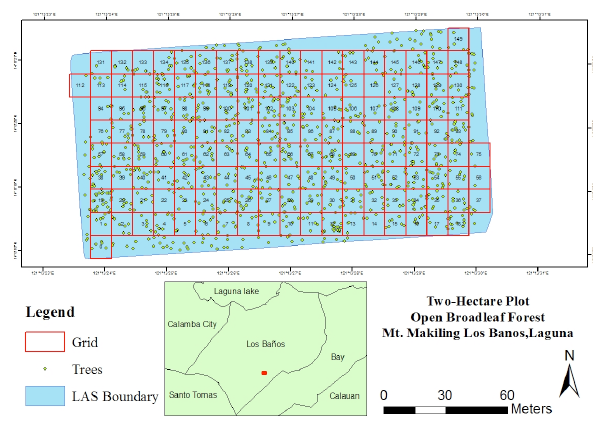
Figure 2: Geotagged trees within the 10x10m grid plots A total of 1,094 trees were surveyed within the two hectares plot. From the 150 grids, 50 random samples were selected to serve as data for calibration for the DBH estimation and also to be comparable to the study of Argamosa (2015) who also used 50 samples.